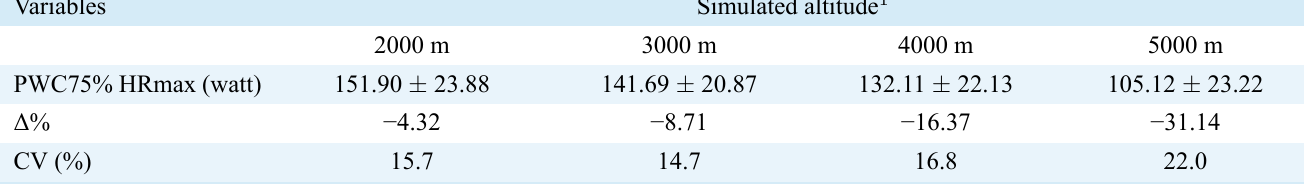
TABLE 6. Descriptive statistics of physical work capacity at 75% HRmax for each simulated altitude.